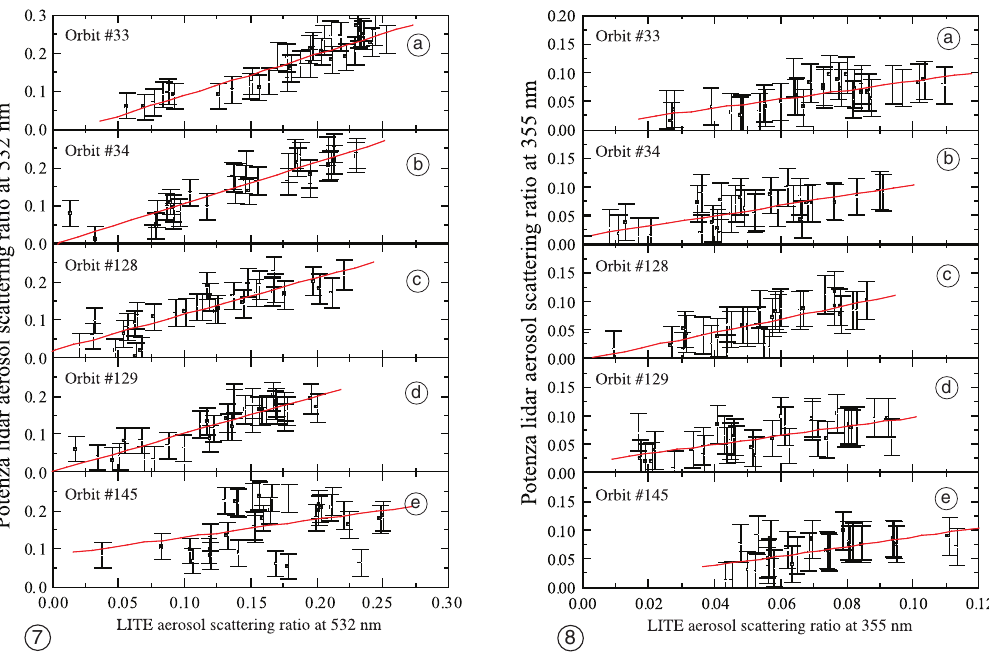
,532LITE ( z ) versus R Pz ( z ) for all data points within the stratospheric aerosol layer: a) orbit 33; Fig. 7a-e. R A A , 532 b) orbit 34; c) orbit 128; d) orbit 129 and e) orbit 145. Values of R Also reported is the best fi t linear function.